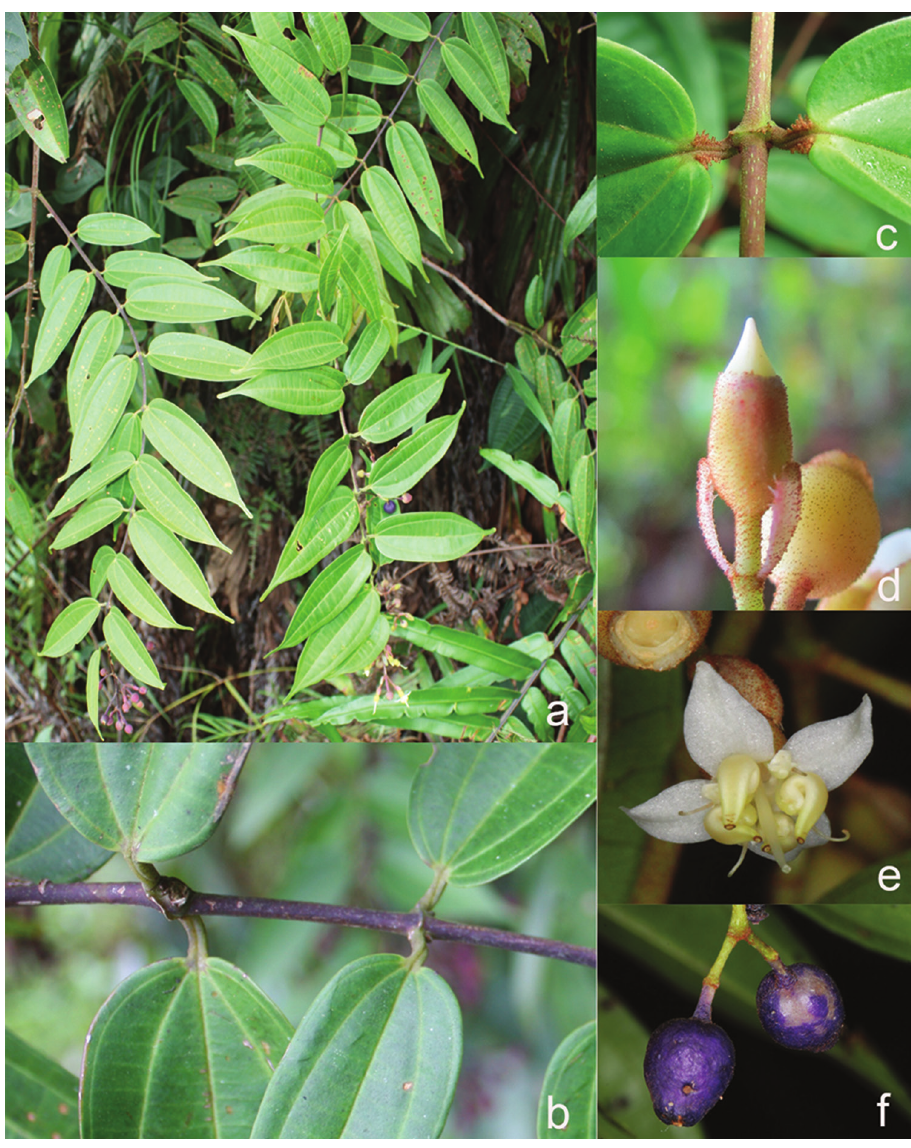
Figure 28. Dissochaeta viminalis . a habit b branchlet c leaf node d hypanthium e flower f fruits. Photo- graphs by A. Kartonegoro; vouchers: Kartonegoro 1075 (BO, L)] hairs at the midrib and nerves. Inflorescences terminal and axillary, when terminal up to 12 cm long, many-flowered, when axillary ones up to 5.5 cm long, 3–9-flowered; main axis stellate-puberulous; primary axes up to 5 cm long with 2–4 nodes, secondary axes up to 2 cm long with 1–3 nodes, tertiary axes when developed up to 0.5 cm long with 1 node; bracts linear or elliptic, 3–6 × 3–4 mm, stellate-puberulous, caducous; bracteoles ovate to oblong, 3–4 mm long, stellate-puberulous, margin ciliate; pedicels